Question: State the chart type depicted above.
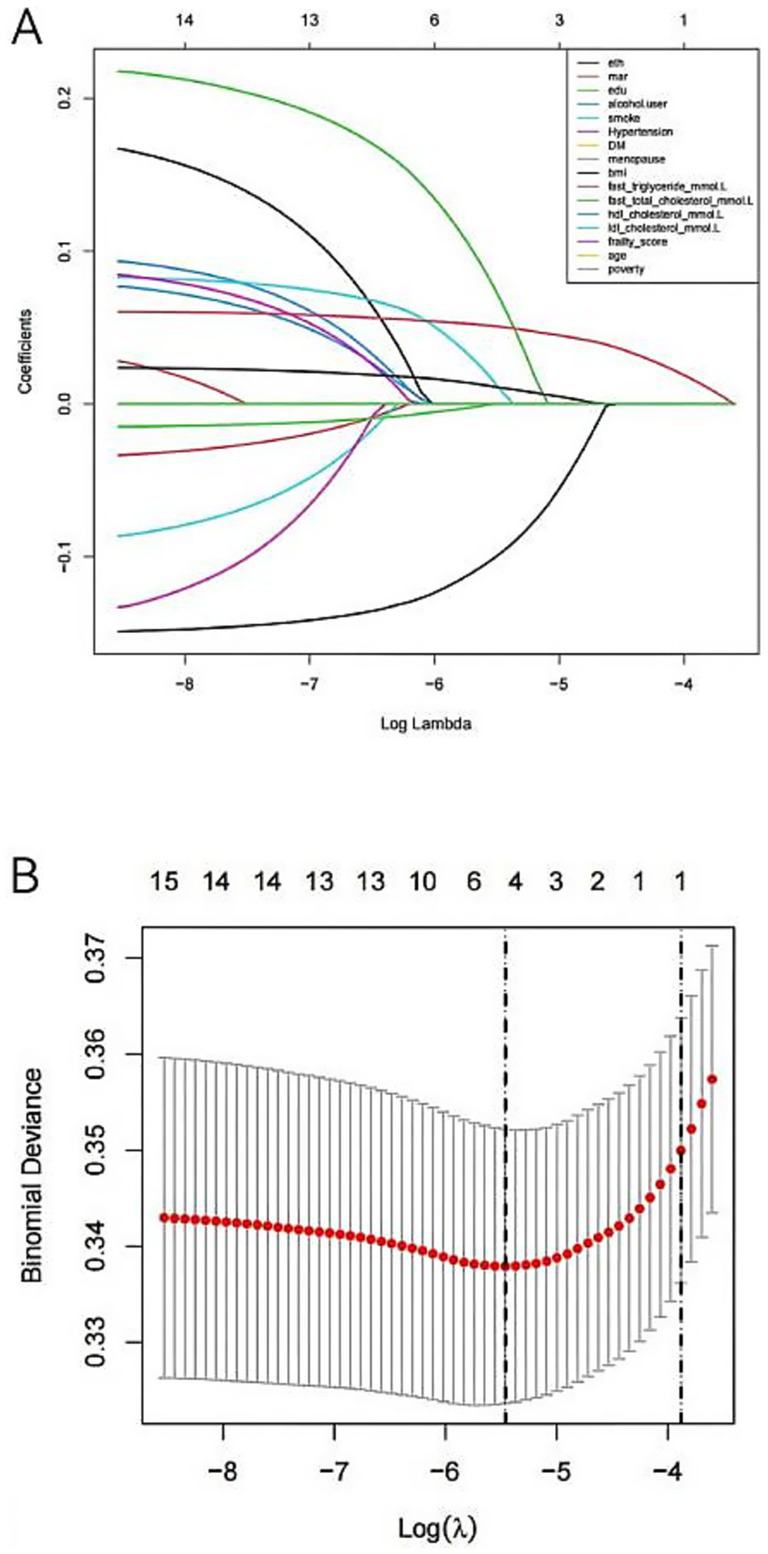
Answer: bar